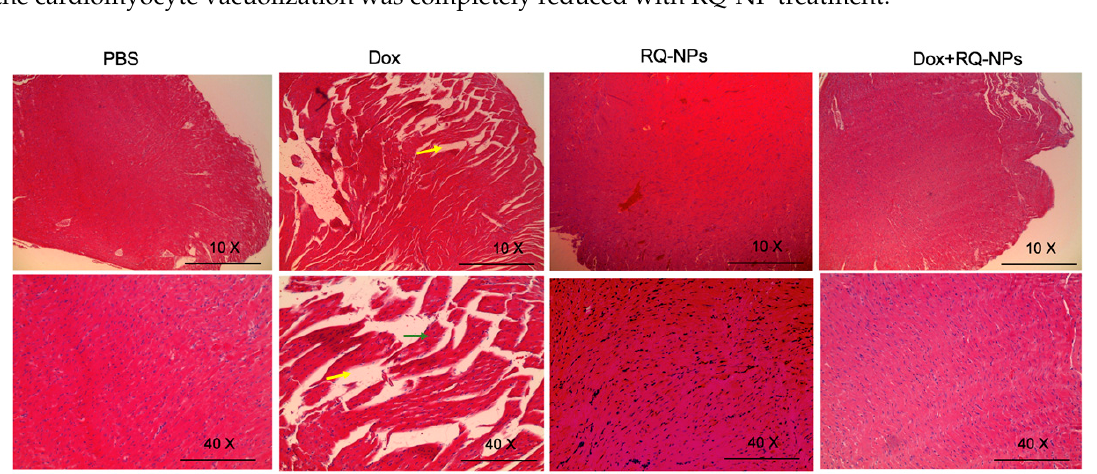
Figure 6. E ff ect of DOX + RQ-NPs, doxorubicin (DOX), and their combination on cardiac tissue histopathology. The control (PBS treated mice) shows normal myocardial morphology. RQ-NP treated mice show normal myocardial morphology. DOX treated mice show damaged hearts with extensive disarrangement, cytoplasmic vacuolization, and cell death (yellow arrows) with macrophage infiltration (green arrow). DOX + RQ-NP treated mice show that the cardiomyocyte vacuolization was completely reduced with Ajwa bioactive compound (BAC)